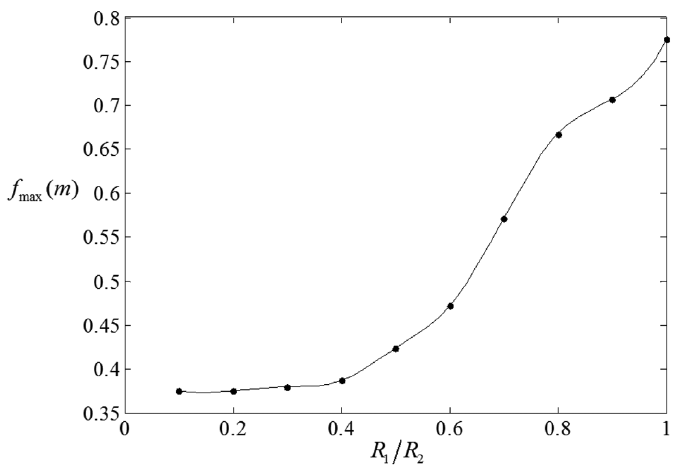
Fig. 12. Maximum amplitude in the time history of the sloshing displacement at the container wall under the Kobe seismic excitation versus R 1 / R 2 for h 1 / R 2 = 0.4. Agency station during the 1995 Hyogo-ken Nanbu (Kobe) earthquake in Japan. A 30 s seismic record is shown in Fig. 11. The sloshing response of liquid in the cylindrical rigid container with a rigid baf fl e is studied under the seismic lateral excitation. We consider the radius of the container R 2 = 10 m and the liquid height h = 10 m . The density of the liquid is 1000 kg / m 3 . The sloshing displacement at the container wall, the resultant hydrodynamic force and the resultant hydrodynamic moment with the center of the bottom are studied for parameters: h 1 / R 2 = 0.4, R 1 / R 2 from 0.1 to 1 and R 1 / R 2 = 0.4, h 1 / R 2 from 0.1 to 1. The maximum amplitude in the time history of the sloshing displacement at the container wall versus R 1 / R 2 for h 1 / R 2 = 0.4 are illustrated in Fig. 12. The maximum amplitude in the time history of the sloshing displacement at the container wall versus h 1 / R 2 for R 1 / R 2 = 0.4